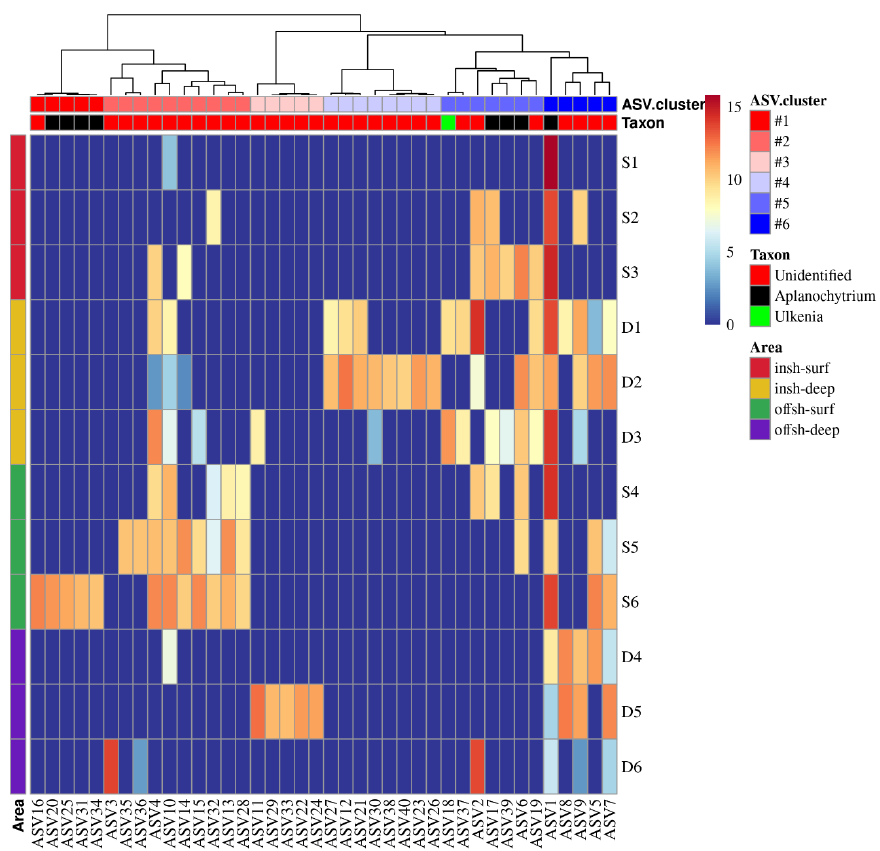
Figure 5. Heatmap illustrating the community structure of the 40 most abundant labyrinthulomycetes ASVs across different zones of inshore and offshore areas. Relative abundances were log2 transformed and scaled, and then clustered by column using Ward’s hierarchical clustering method. The ASVs were classified to the genus level. S: surface water; D: deep water; numbers after “S” or “D” indicate sampling